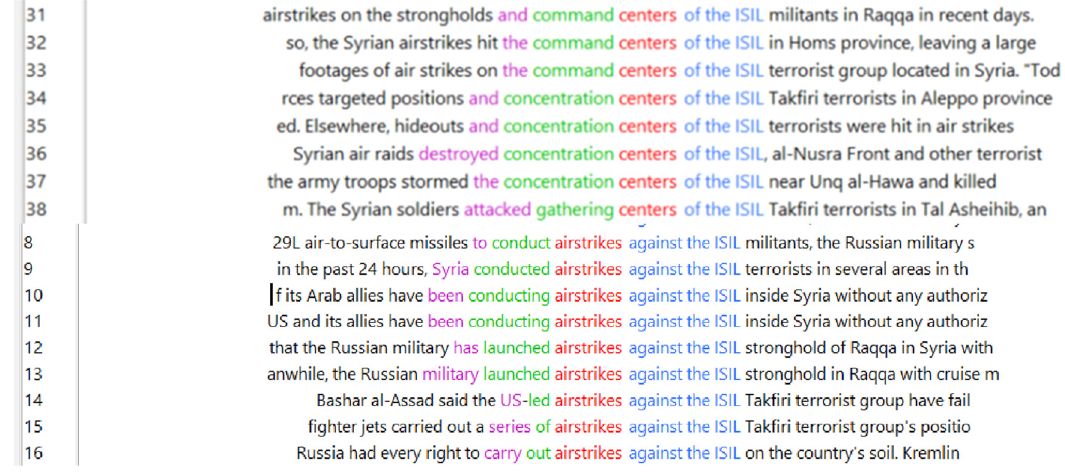
Figure 6: The concordances for of the ISIL and against the ISIL patterns.